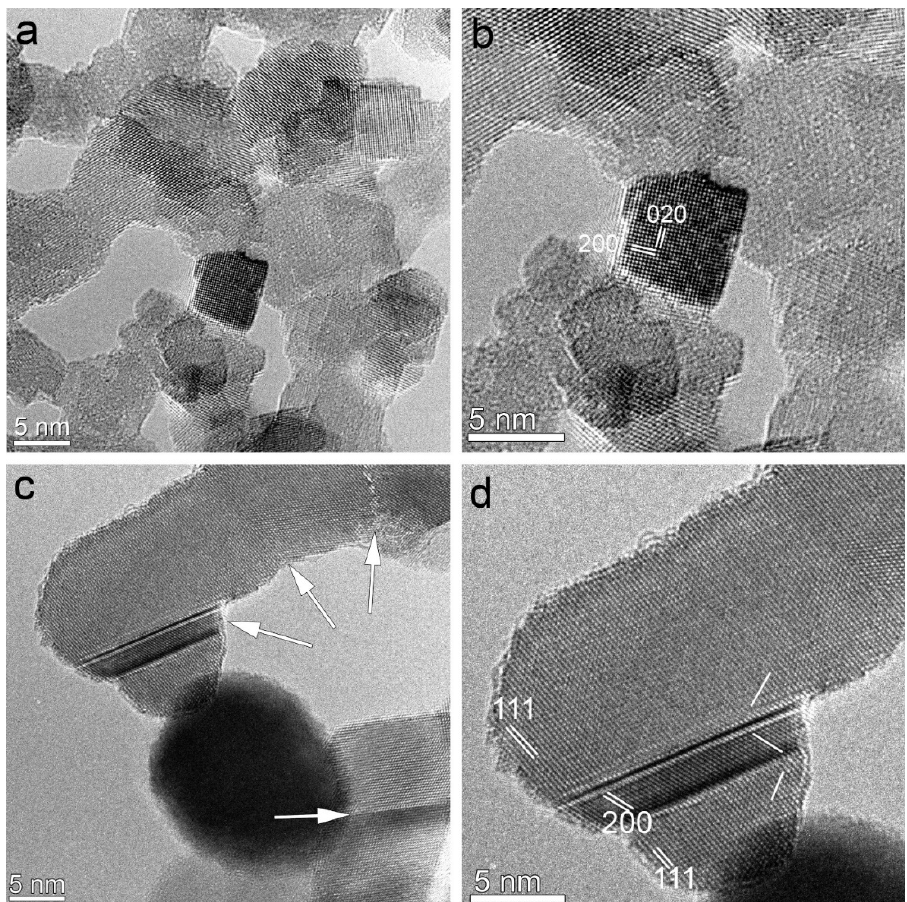
Figure 4. HRTEM micrographs revealing the differences between the samples calcined at 400 °C ( a , b ) and 500 °C ( c , d ) in terms of nanoparticles size, shape, surface roughness, and presence of crystallographic defects. The white arrows in ( c ) point to typical planar defects observed inside a large single crystal nanoparticle in [01-1] orientation (sample calcined at 500 °C). The parallel planar defects in ( d ) are ( − 111) twin boundaries, while the zig-zag white line indicates the trace of the (200) crystallographic planes inside the nanoparticle across the twin boundaries.